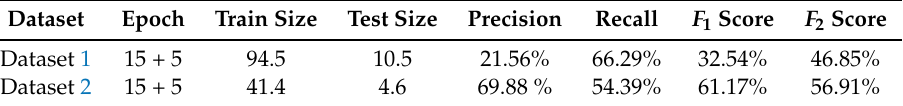
Table 4. The results of the effect of specialization in dataset.